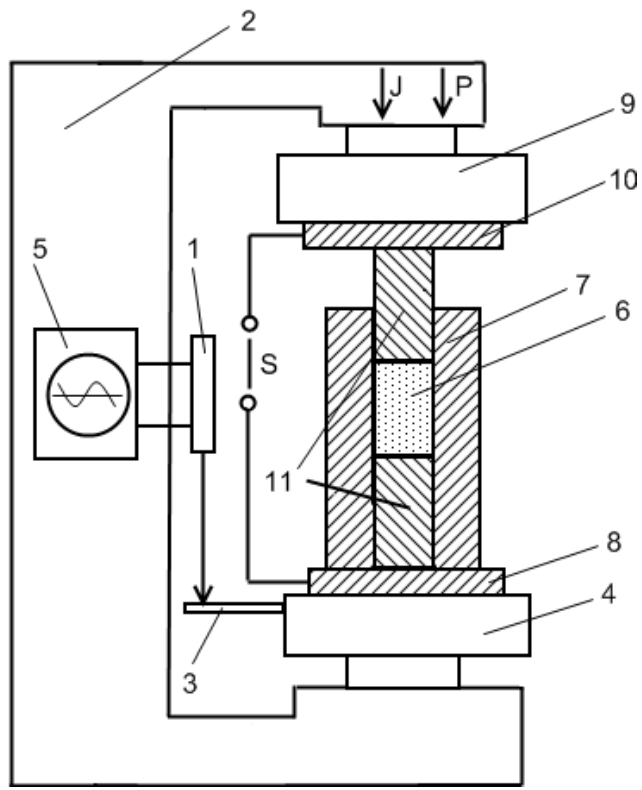
Figure 24. Schematic of an electric discharge sintering set-up.